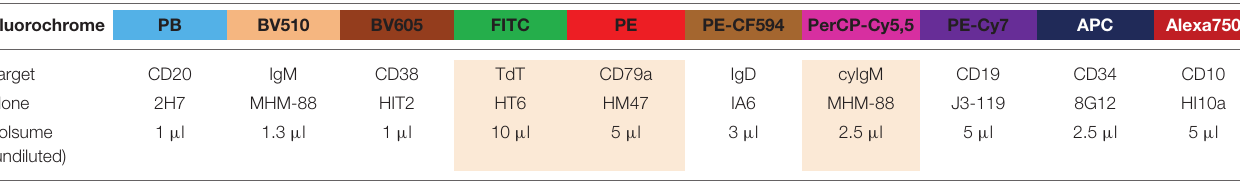
Shaded fields indicate intracellular